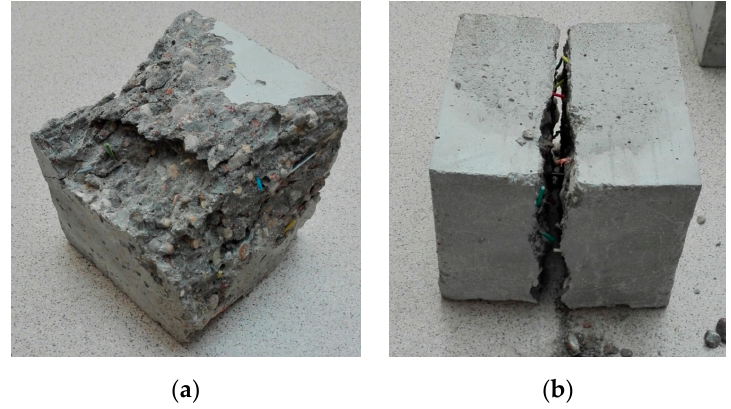
Figure 5. Cubic samples after testing of the ( a ) compressive strength and ( b ) splitting tensile strength.